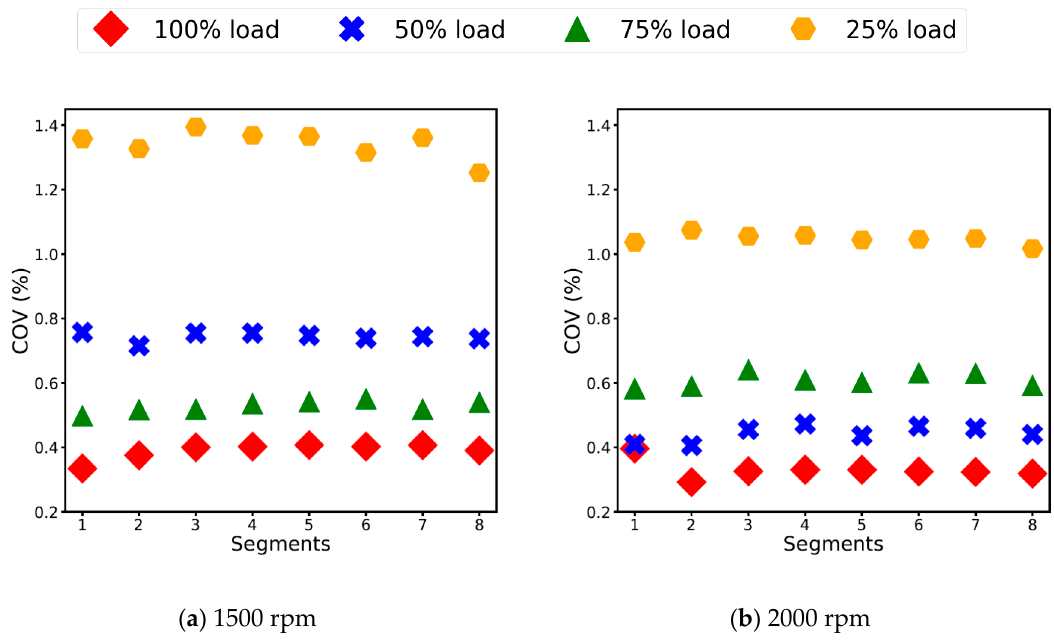
Figure 2. COV of IMEP at all loads in each stage at ( a ) 1500 rpm and ( b ) 2000 rpm. The red thick diamond represents 100% load, the blue thick cross 50% load, the green triangle 75% load and the orange hexagon 25% load.